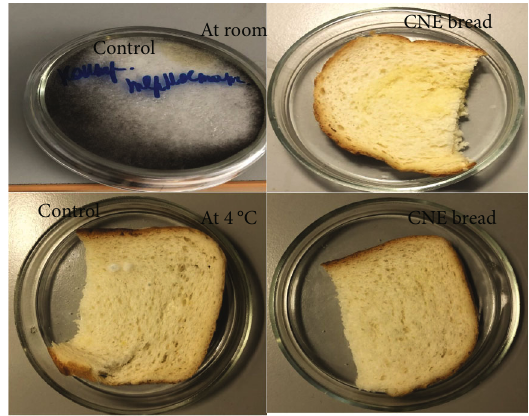
Figure 8: Microbial growth on bread sample during room temperature and refrigerator after 7